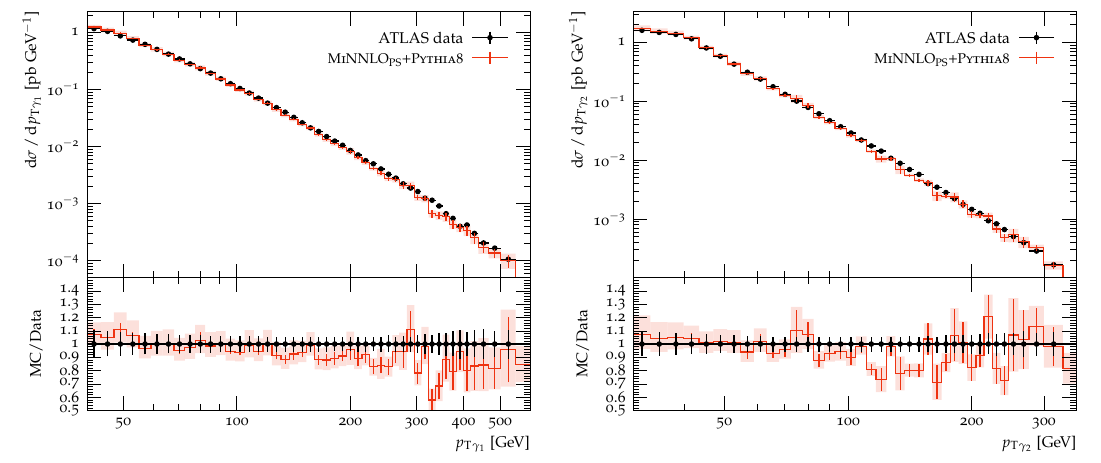
Figure 10 . Comparison between the ATLAS data and the distributions obtained with MiNNLO Pythia8 , for the transverse momentum of the leading and subleading photon. Scale- PS + variation bands are also shown, together with the statistical errors of the central